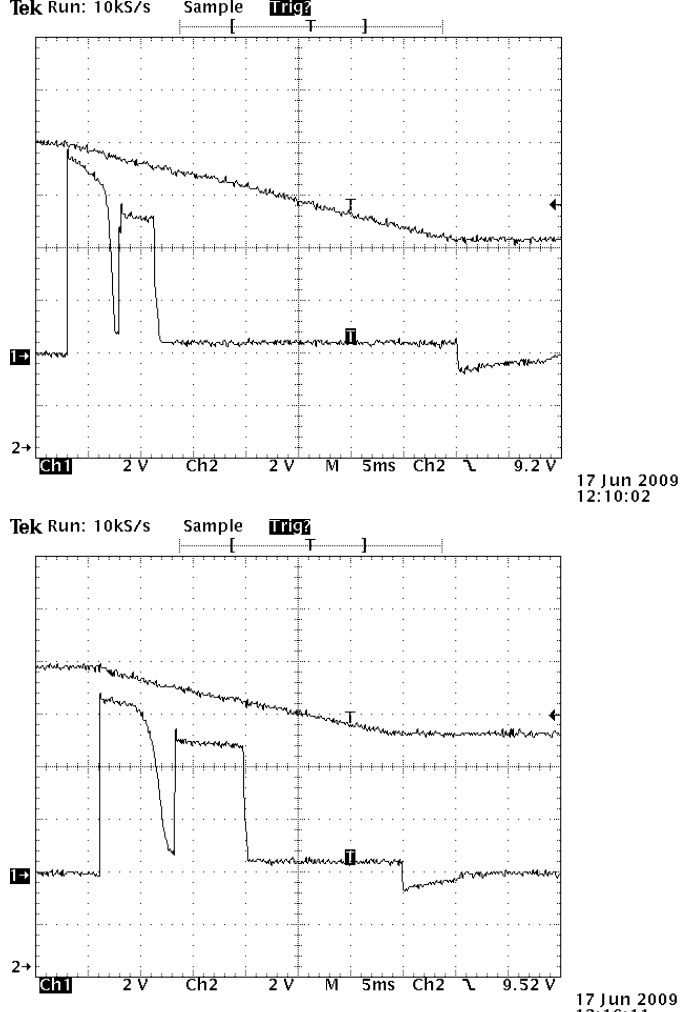
Figure 9. Ch1 is the current that triggers the solenoid and ch2 is the voltage of the capacitor of 3.3